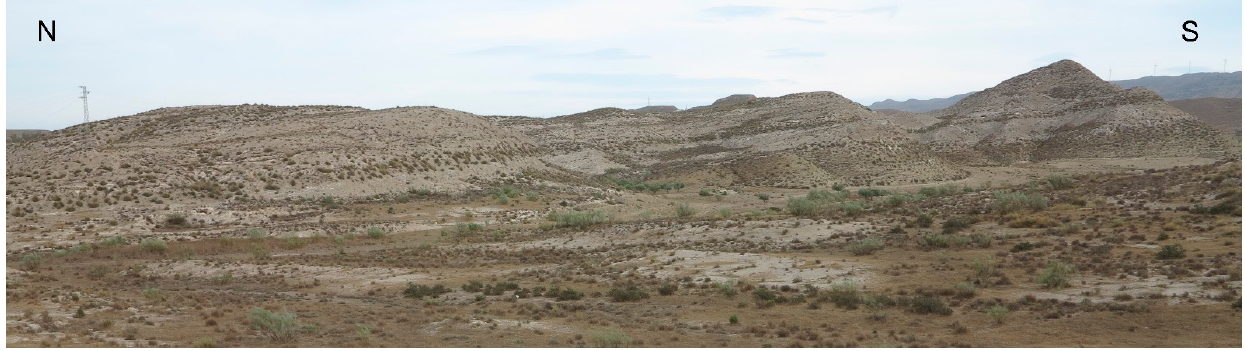
Figure 2. Panoramic view (N–S) of the studied area. The continuity of the gypsum banks can be observed with a gentle dip to the north. observed with a gentle dip to the